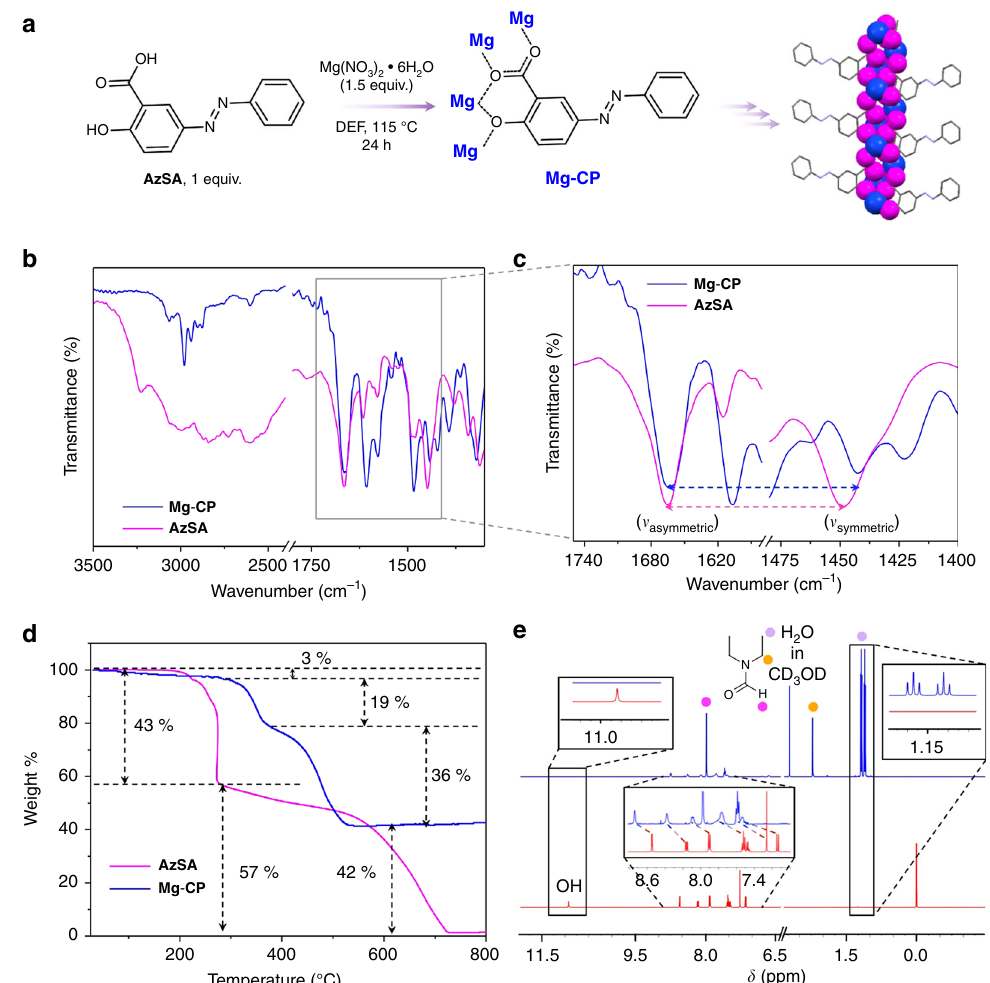
Fig. 2 Synthesis and characterization of Mg-CP . a Reagents and conditions for the synthesis of the coordination polymer Mg-CP from organic ligand AzSA . Schematic representation of coordination modes in Mg-CP . Blue and magenta represent magnesium and oxygen atoms, respectively. b FT-IR spectra of AzSA and Mg-CP showing changes in the region corresponding to O-H stretching and the asymmetric and symmetric stretching frequencies of the carbonyl bond. c Expanded portion of the region (1750 – 1400 cm − 1 ), showing the differences in the asymmetric and symmetric stretching bands of the carbonyl bond. d TGA of Mg-CP and AzSA . e 1 H NMR spectra of Mg-CP (blue) and AzSA (red) (500 MHz, CD 3